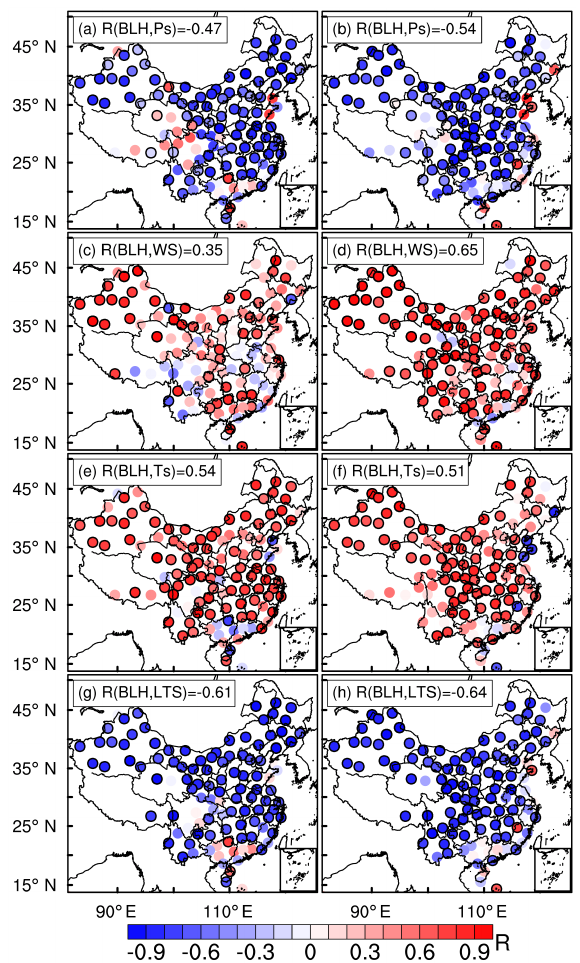
Figure 13. Correlations ( R ) between mean annual cycles (12- monthly values) of CMA-BLH and (a, b) surface pressure ( P s ), (c, d) 10m wind speed, (e, f) near-surface temperature ( T s ) and (g, h) lower tropospheric stability (LTS), at 08:00 (left panels) and 20:00BJT (right panels). Symbols outlined in black indicate values that are statistically significant ( p < 0.05), and the overall mean R is given for each panel as